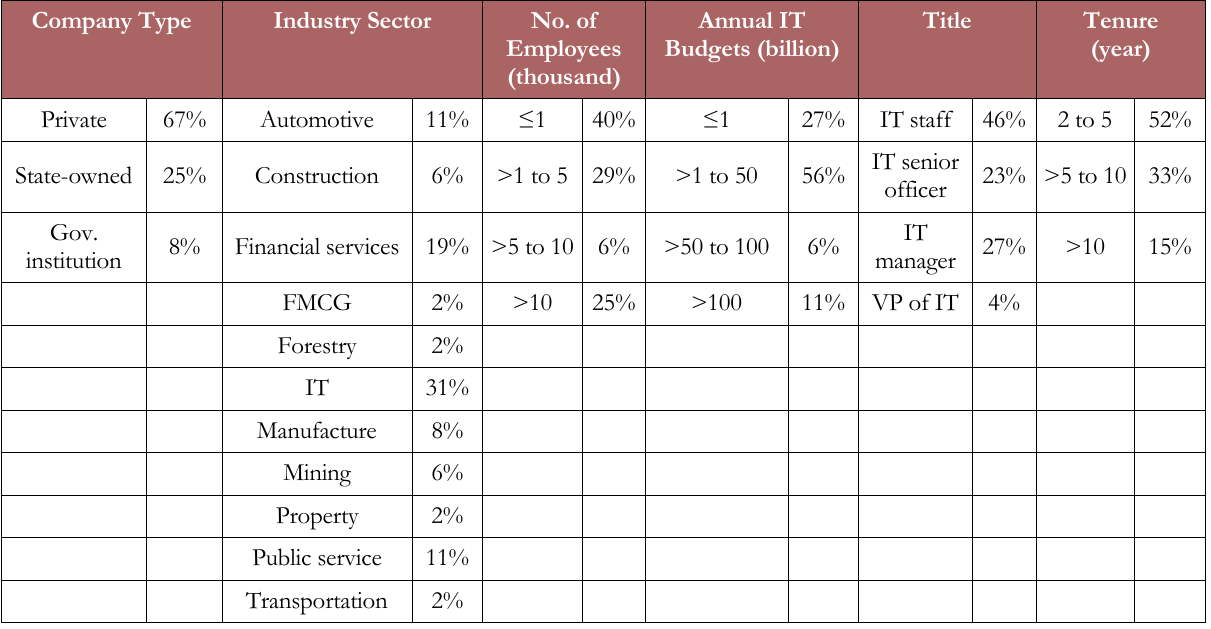
Table 2. Demographic characteristics of